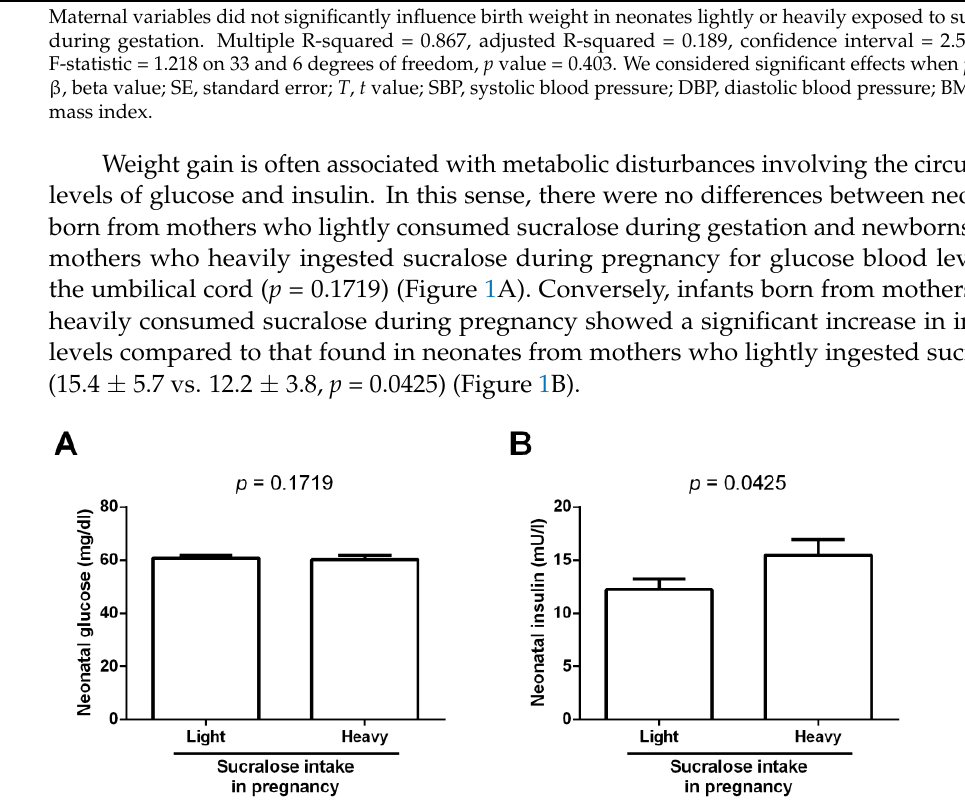
Figure 2. Gating strategy for detecting classical, intermediate, and nonclassical monocyte subsets in neonates lightly or heavily exposed to sucralose during pregnancy. CD14++CD16- cells were recog- nized as classical monocytes, CD14++CD16+ cells were identified as intermediate monocytes, and CD14+CD16+ cells were distinguished as nonclassical monocytes. The last panel illustrates how nonclassical monocytes significantly increase in neonates from mothers who intensely consumed sucralose during pregnancy. We acquired 1x10 4 cell events per test in triplicate corresponding to the HLA-DR+ cell population on a BD influx flow cytometer.